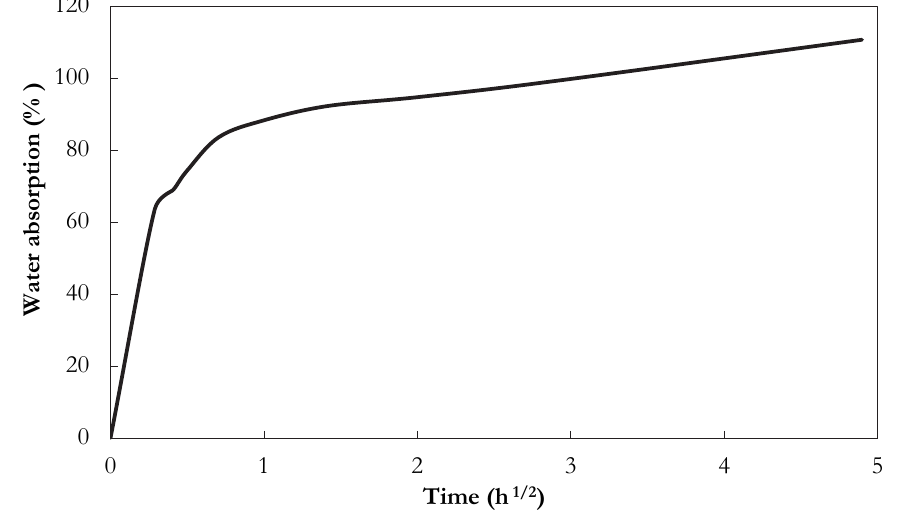
Figure 7: Water absorption kinetics of date palm